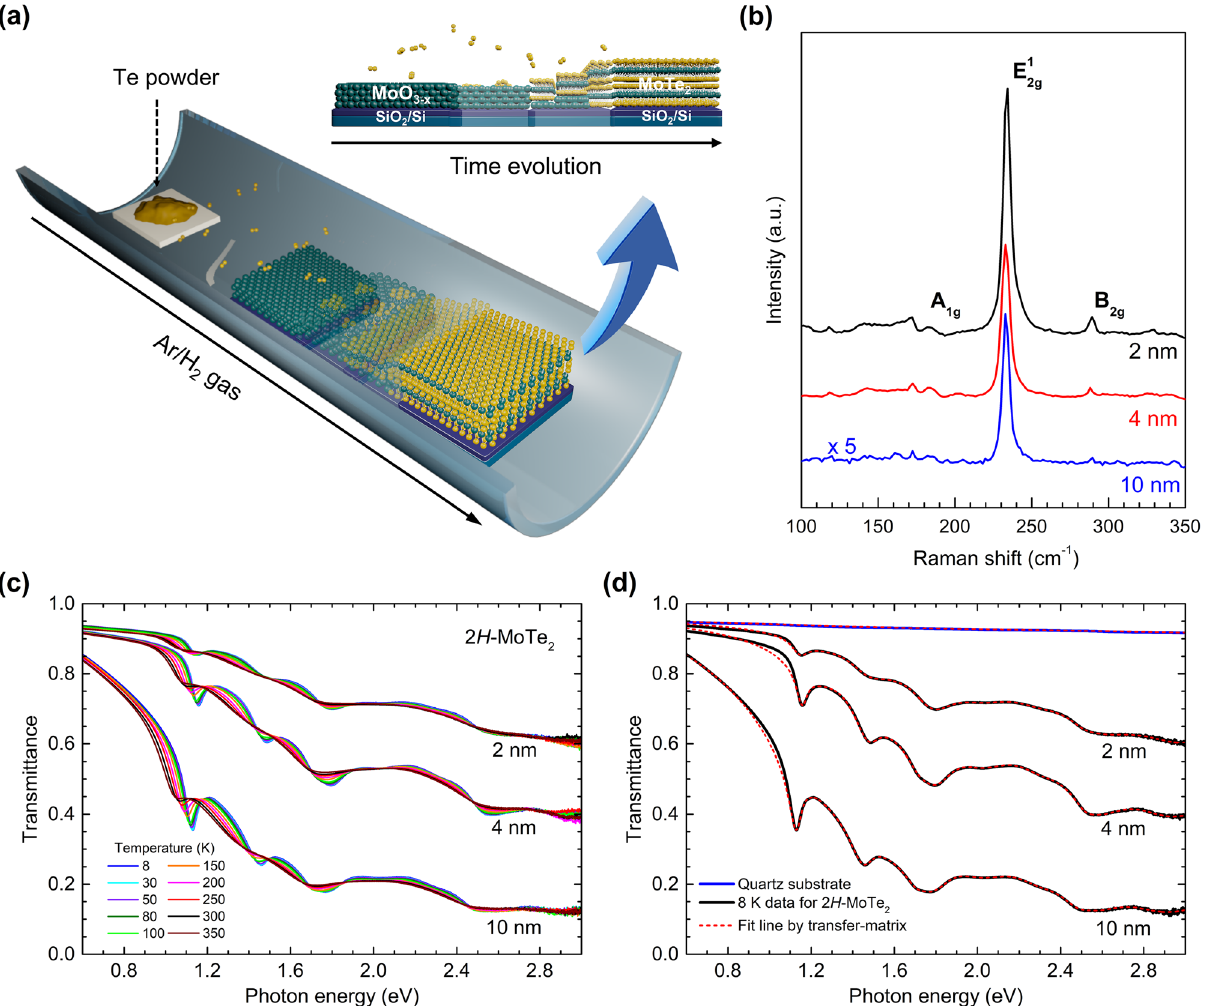
Figure 1. Synthesis of 2H-MoTe 2 film and measurement transmittance spectra. ( a ) Schematic of chemical vapor deposition system used to synthesize 2H-MoTe 2 film on SiO 2 /Si substrate and illustration of growth process. The oxidized Mo thin film transformed gradually to the 2H-MoTe 2 film as the processing time goes. ( b ) Thickness-dependent Raman spectra with three different thicknesses (2, 4, and 10 nm). ( c ) Measured transmittance spectra for 2H-MoTe 2 films at various temperatures between 8 and 350 K. ( d ) Measured transmittance spectra of the three samples and their simulated spectra by using the transfer matrix method at 8 K. The transmittance and fit of quartz substrate are also